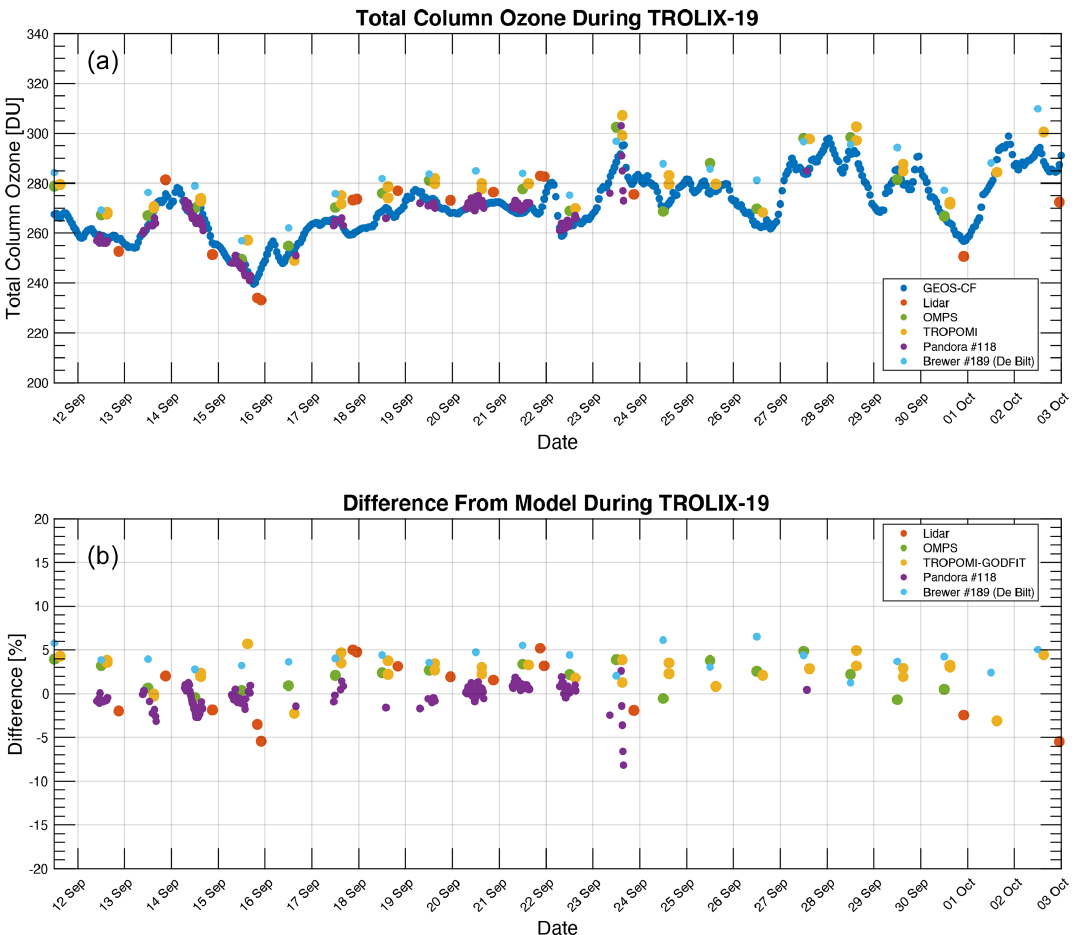
Figure 8. Total ozone columns (a) and percent differences (b) as compared to the model observations for GEOS-CF, lidar, OMPS, TROPOMI, Pandora and